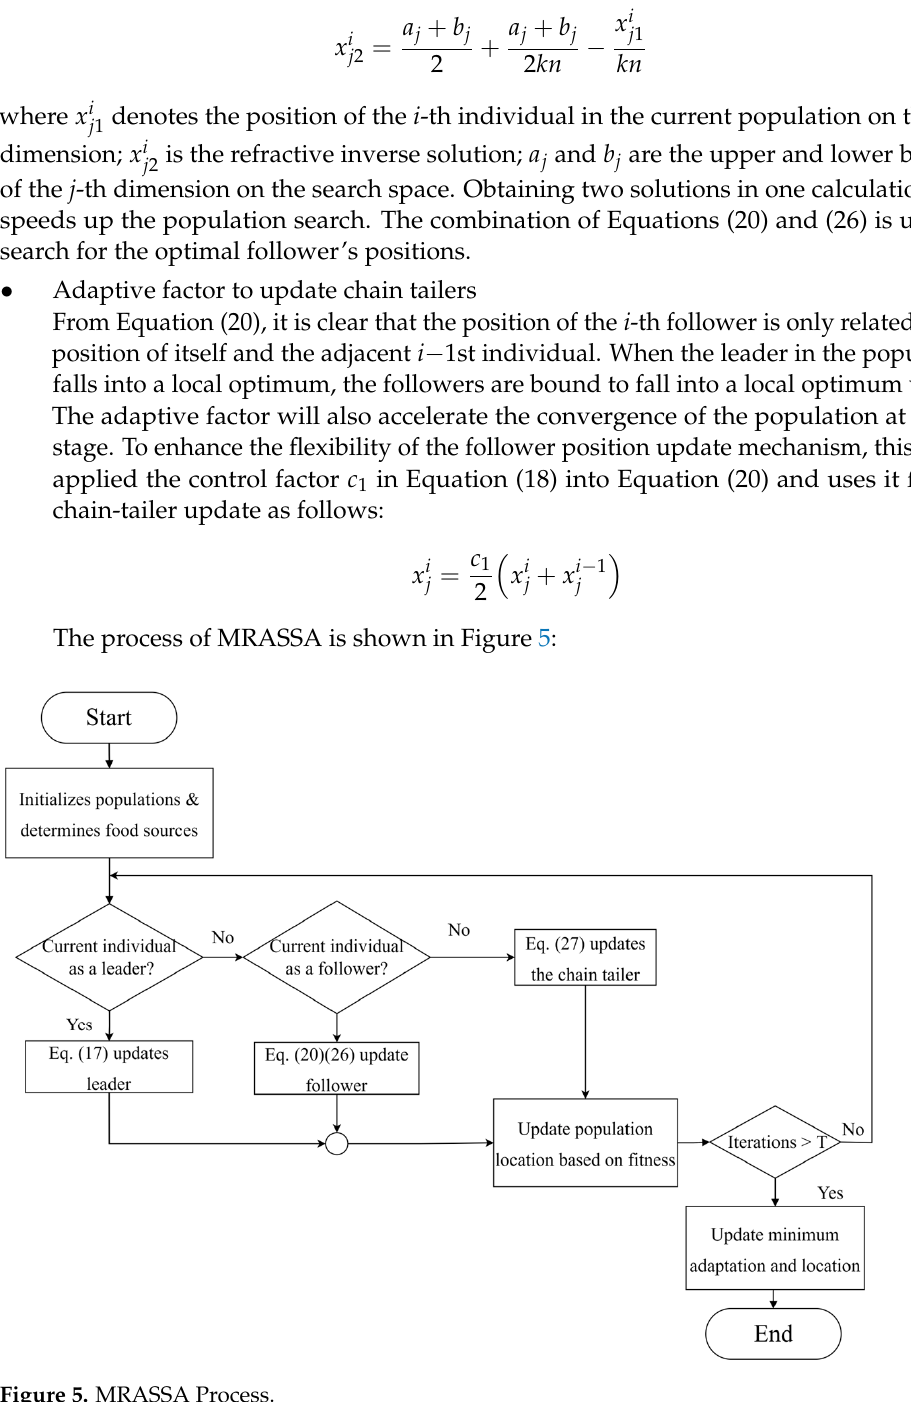
Figure 5. MRASSA Process.